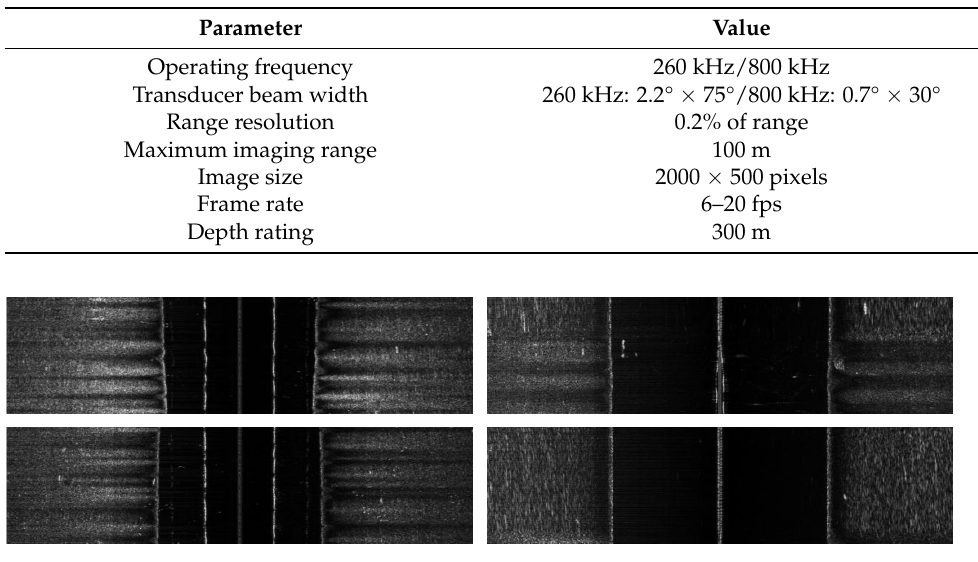
Figure 8. The obtained SSS image containing the small targets. They were collected in different